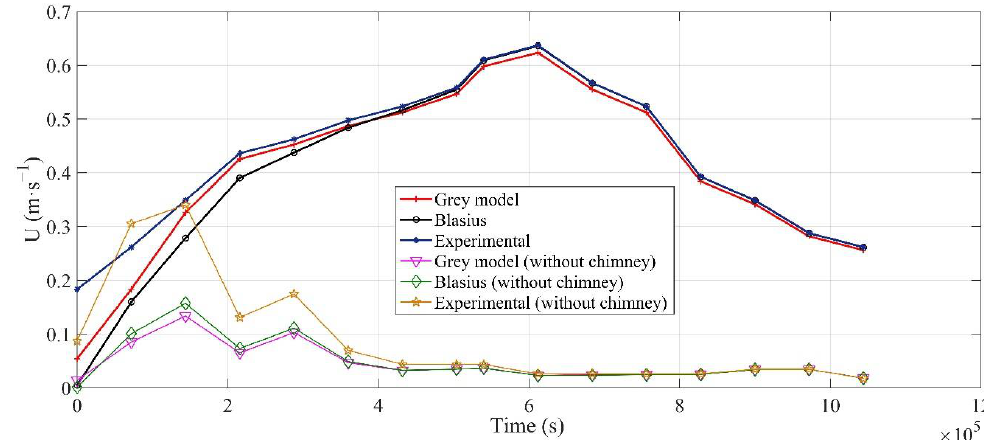
Figure 6. Comparison of the experimental value with the grey and analytical models.